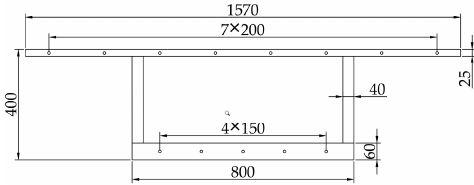
Figure 2. Simplified cross-section of box girder (unit: cm).